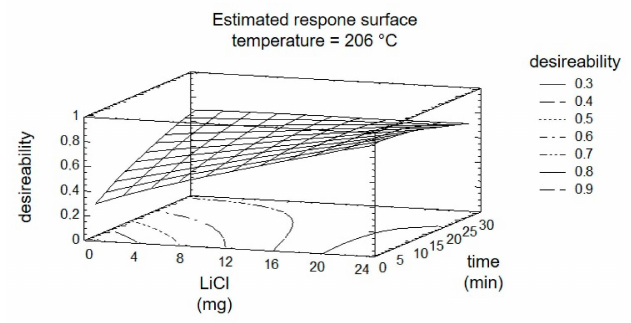
Figure 7. Estimated response surface fixing the temperature at 206 ◦